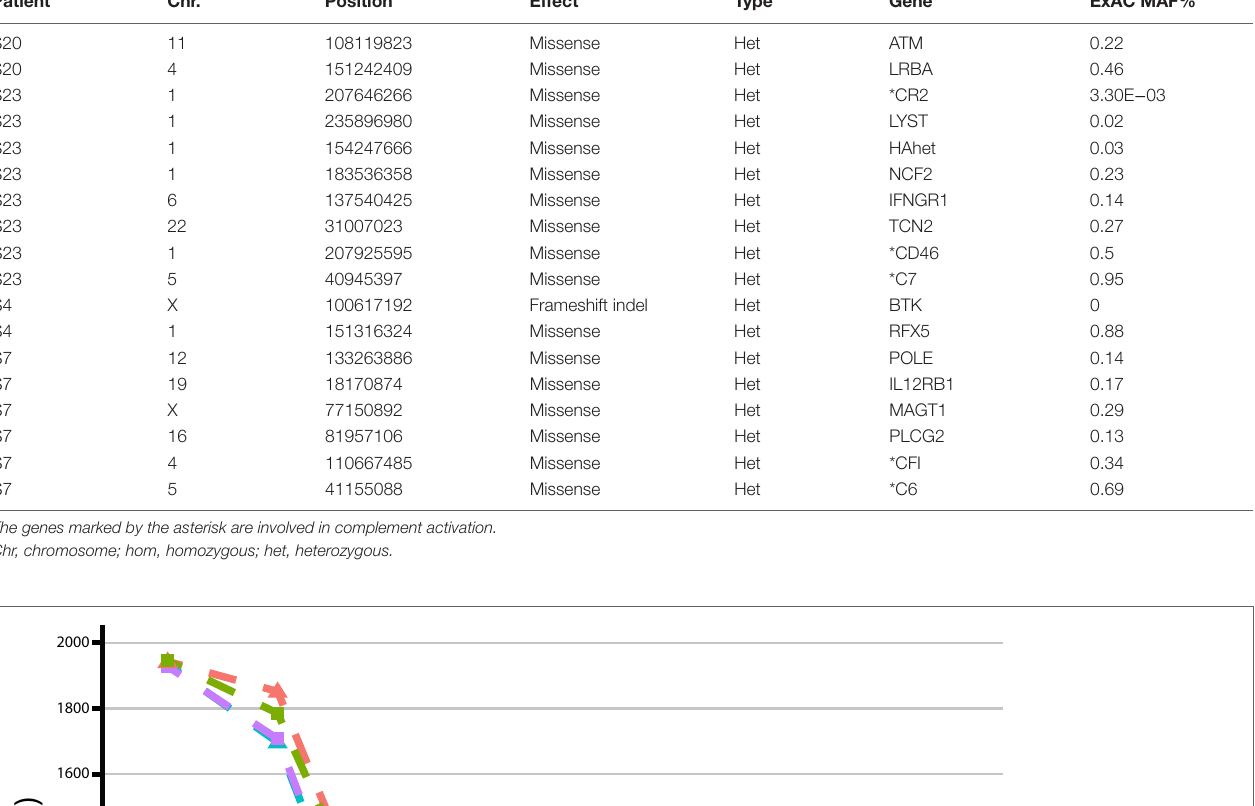
FigUre 2 | Titration of serum with/without c9 in a study patient with a heterozygous stop-gain variant in the C9 gene .